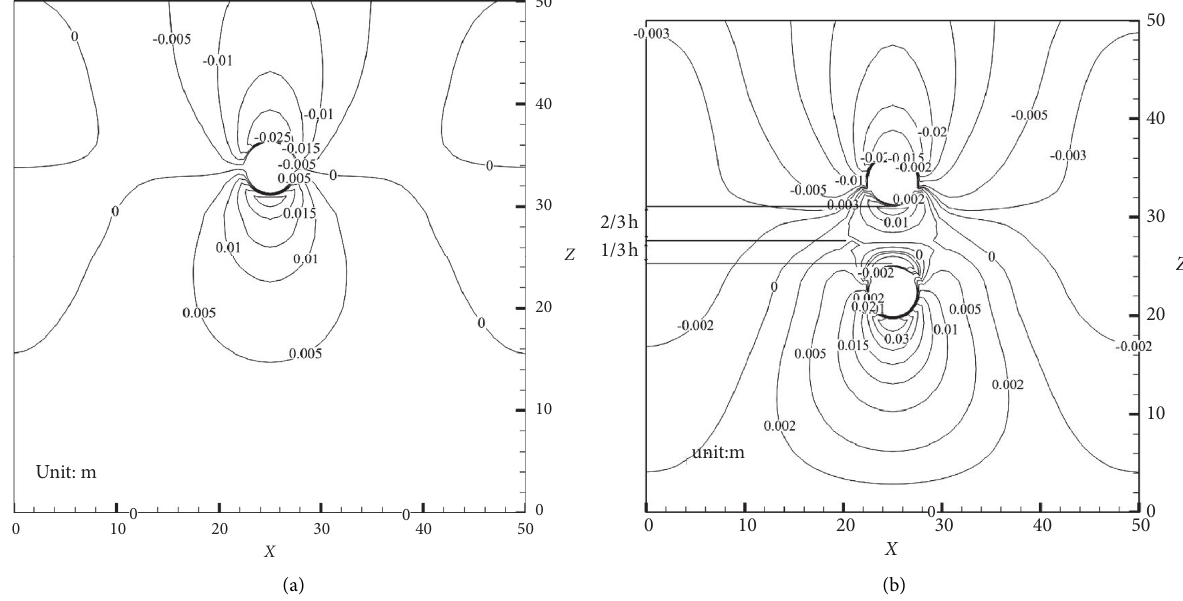
Figure 8: (a) Contour map of the vertical displacement of the stratum after the excavation of the upper tunnel. (b) Contour map of the vertical displacement of the stratum after the excavation of the lower tunnel (h: the distance between the upper and lower